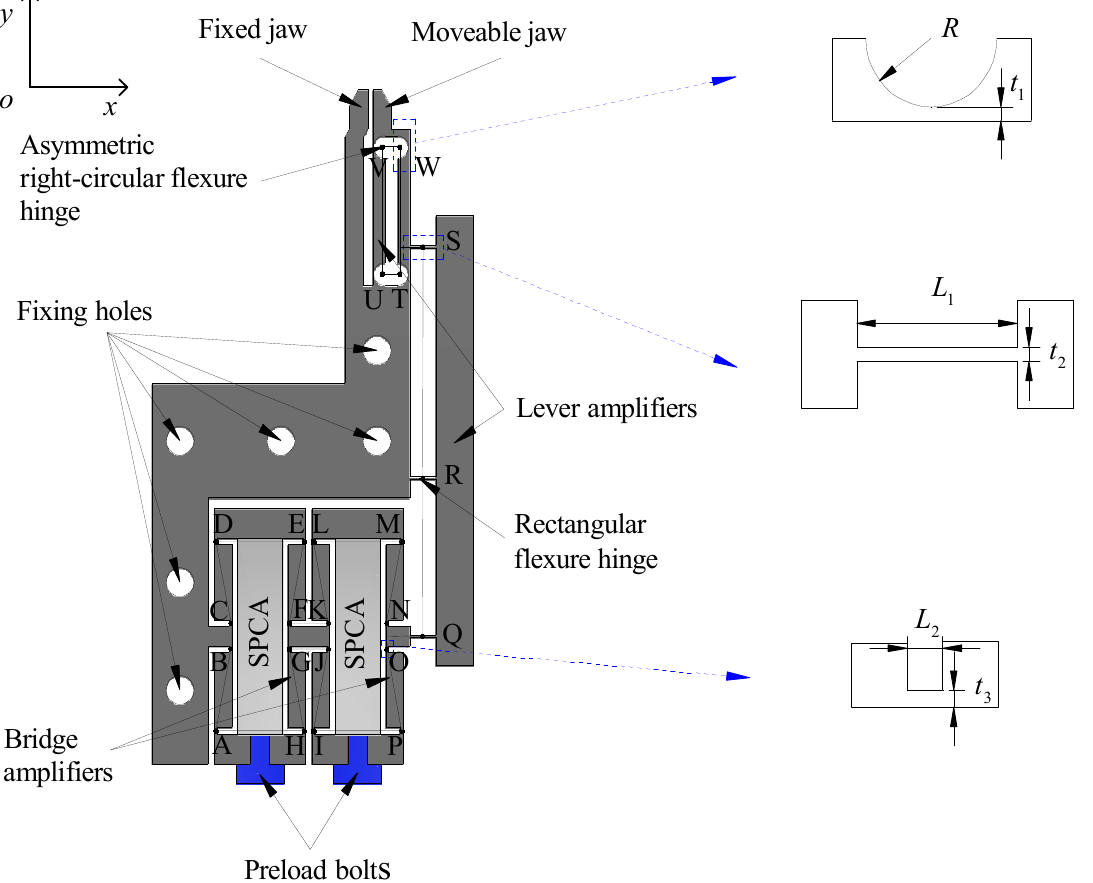
Figure 1. Main view of the microgripper. SPCA, stacked piezoelectric (PZT) ceramic actuator.